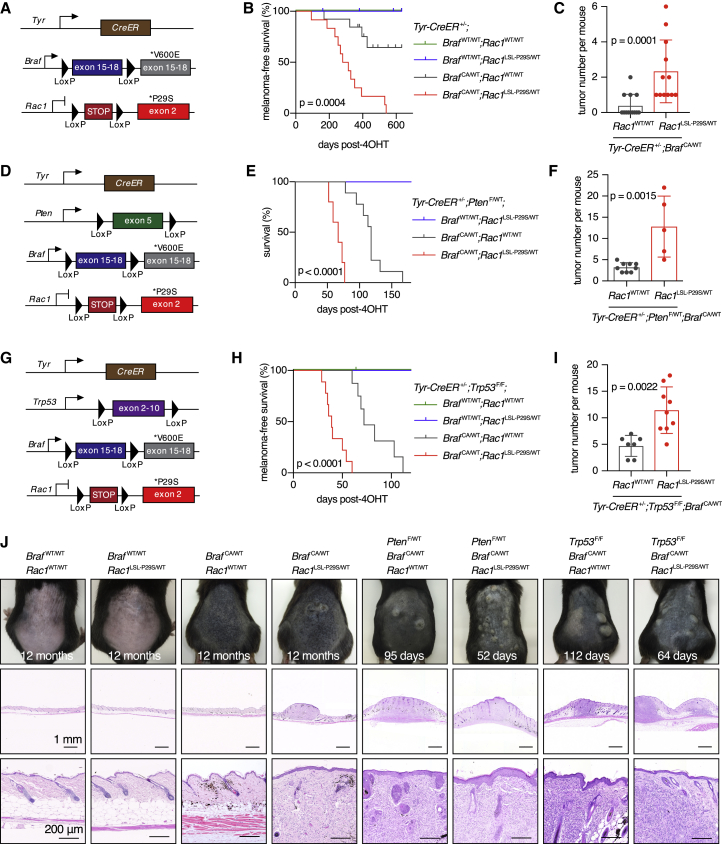
Effect of Melanocytic Expression of RAC1P29SIn Vivo on Tumorigenesis(A) Schematic of the Tyr-CreER, BrafCA and Rac1LSL−P29S allele combination.(B) Melanoma-free survival curves of Tyr-CreER+/–;BrafCA/WT;Rac1WT/WT mice and Tyr-CreER+/–;BrafCA/WT;Rac1LSL−P29S/WT mice were compared using log rank testing (Mantel-Cox).(C) Effects of RAC1P29S on tumor number in Tyr-CreER+/–;BrafCA/WT mice. Groups were compared using the Mann-Whitney test (n = 12–13 mice per genotype).(D) Schematic of the Tyr-CreER, PtenF, BrafCA, and Rac1LSL-P29S allele combination.(E) Overall survival curves of Tyr-CreER+/–;PtenF/WT;BrafCA/WT;Rac1WT/WT mice and Tyr-CreER+/–;PtenF/WT;BrafCA/WT;Rac1LSL−P29S/WT mice were compared using the log rank testing (Mantel-Cox).(F) Effects of RAC1P29S on tumor number in Tyr-CreER+/–;PtenF/WT;BrafCA/WT mice. Groups compared using Mann-Whitney testing (n = 5–9 mice per genotype).(G) Schematic of the Tyr-CreER, Trp53F, BrafCA, and Rac1LSL−P29S allele combination.(H) Melanoma-free survival curves of Tyr-CreER+/–;Trp53F/F;BrafCA/WT;Rac1WT/WT mice and Tyr-CreER+/–;Trp53F/F;BrafCA/WT;Rac1LSL−P29S/WT mice were compared using log rank testing (Mantel-Cox).(I) Effects of RAC1P29S on tumor number in Tyr-CreER+/–;Trp53F/F;BrafCA/WT mice. Groups compared using an unpaired two-tailed t test (n = 7–9 mice per genotype).(J) Representative photographs and histology of the dorsal skin of various mouse melanoma models. All mice are Tyr-CreER+/–, with additional alleles indicated. Time since 4OHT treatment is indicated.For all graphs: bars represent means ± SD. See also Figure S6.